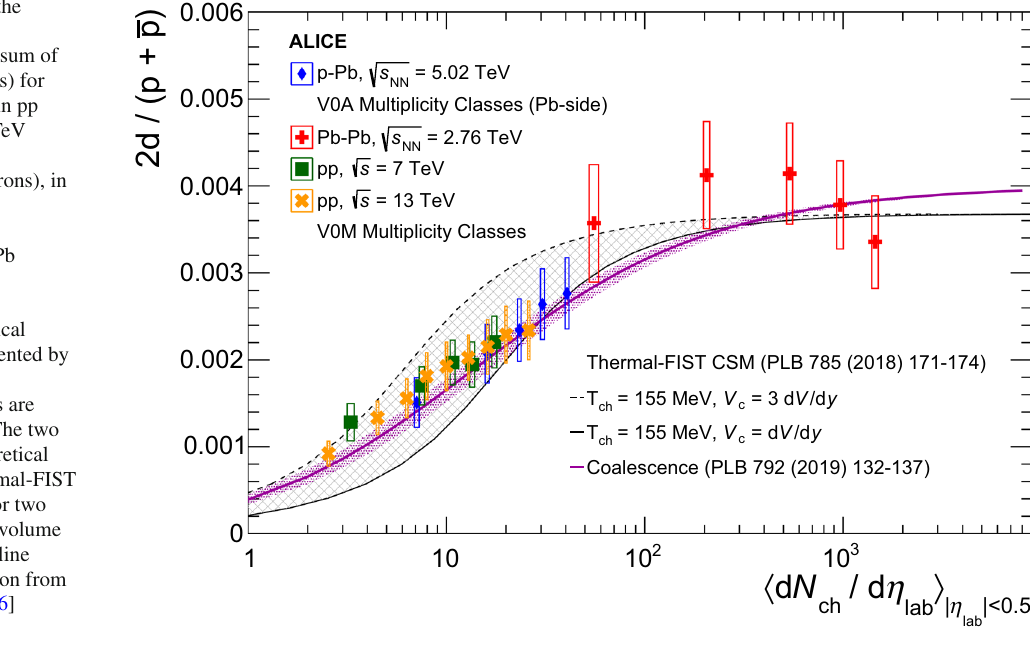
Fig. 5 Ratio between the p T -integrated yields of deuterons and protons (sum of protons and anti-protons) for different multiplicities in pp √ s = 13 TeV collisions at (anti-deuterons) and in √ s = 7 TeV [8] (deuterons), in p–Pb collisions at √ s NN = 5 . 02 TeV [9] (deuterons) and in Pb–Pb collisions at √ s NN = 2 . 76 TeV [1] (deuterons). The statistical uncertainties are represented by vertical bars while the systematic uncertainties are represented by boxes. The two black lines are the theoretical predictions of the Thermal-FIST statistical model [14] for two sizes of the correlation volume V C , while the magenta line represents the expectation from a coalescence model